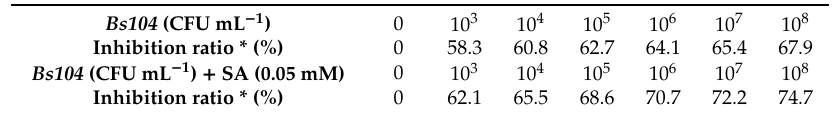
Table 2. The inhibitory effect of B. subtilis 10–4 ( Bs104 ) and B. subtilis 10–4 + salicylic acid (SA) on the growth of F. culmorum mycelium.